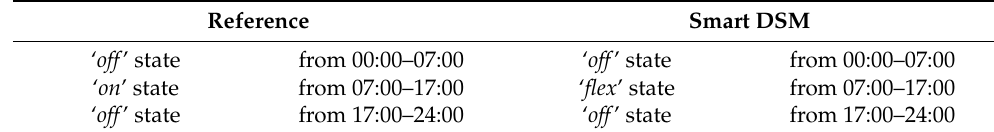
Table 4. Schedule for the reference case of the industrial grid with all loads in full operation mode and the optimized case via the Smart DSM approach with all machines marked as flexibilities during the working day. In ‘ off ’ state all machines are switched off, in ‘ on ’ state all machines are turned on and in ‘ flex ’ state the optimization algorithm decides, which operation state is to be chosen.